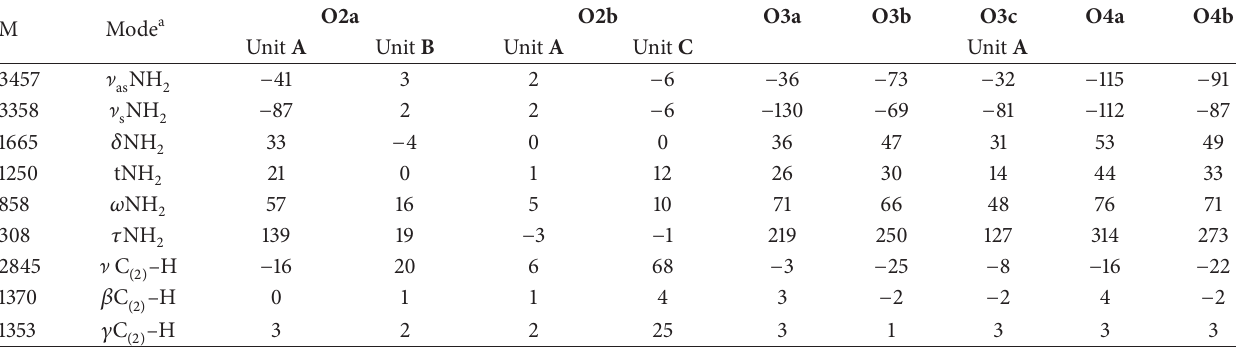
Table 2: CP-corrected vibrational frequency shifts predicted with B97D functional for the NH nomenclature according to Figure